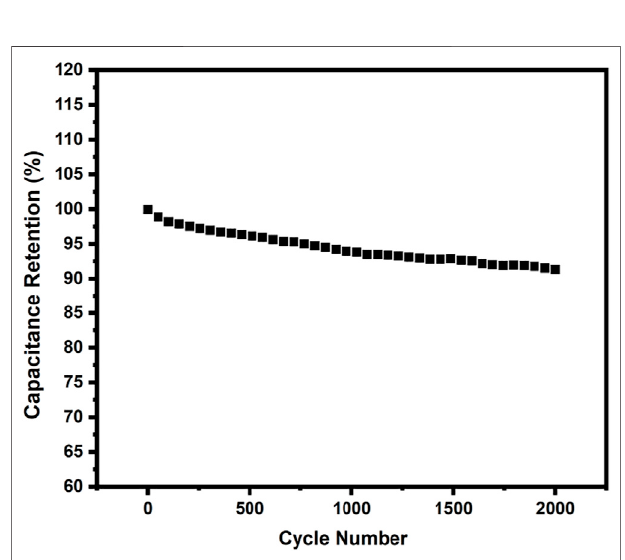
FIGURE 10 | Cyclic stability of p-4CzPN polymer at a current density of 2 A g − 1 (retained about 91% after 2000 cycles).